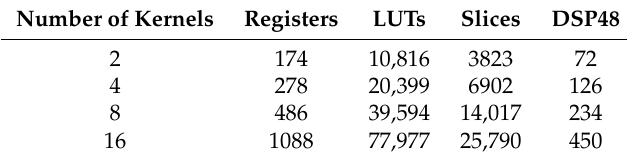
Table 7. Resource utilization of the Iris dataset—floating